Question: Provide a one-line summary of what is displayed.
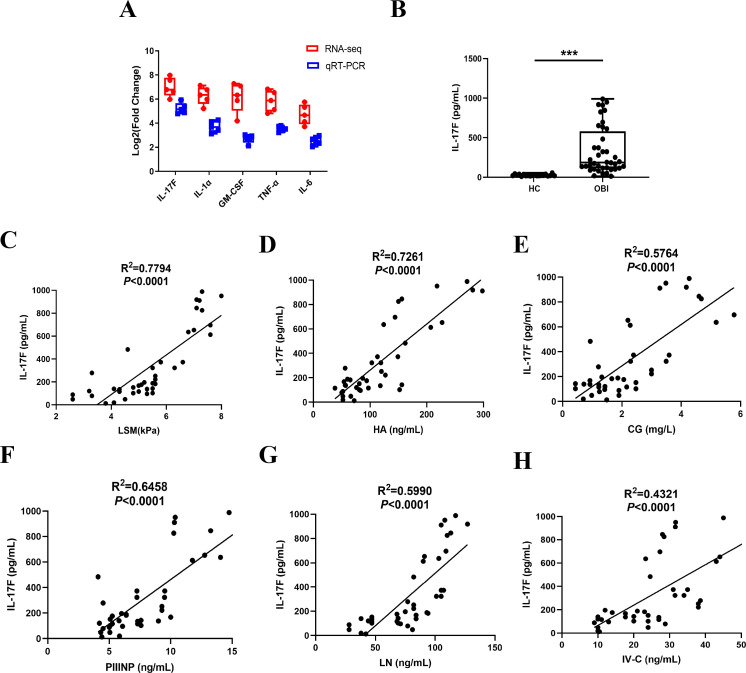
Answer: The quantitative detection and regression analysis of IL-17F. ( A ) Relative fold changes of IL-17F mRNA and the expression of IL-17F correlated DEGs in PBMC samples from OBI donors versus healthy controls (HC), as determined by RT-qPCR and RNA-seq. ( B ) Comparison of IL-17F levels in PBMC culture supernatants between the two groups. ( C ) Linear regression analysis between IL-17F levels and LSM values. ( D–H ) Linear regression analysis between IL-17F levels and individual liver fibrosis indexes. In panels A and B , differences between OBI and HC groups were analyzed using independent two-tailed Student’s t -test. For panels C–H , Pearson correlation coefficients and linear regression lines are shown. * P < 0.05, ** P < 0.01, and *** P < 0.001.